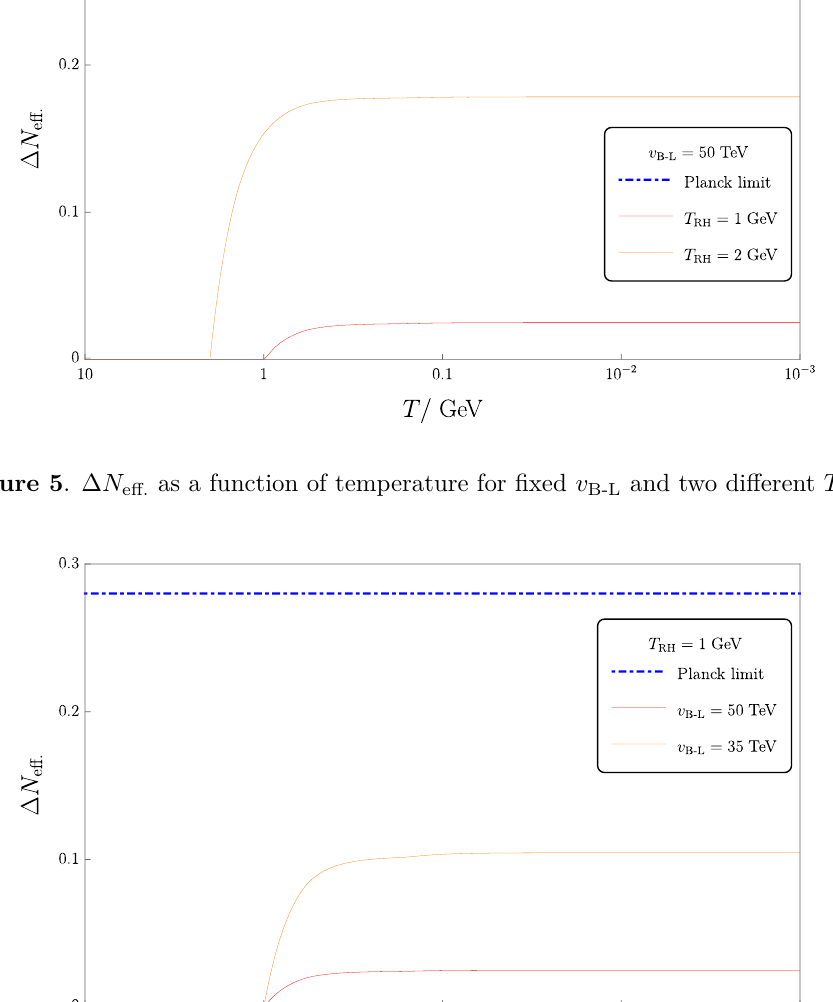
relativistic degrees of freedom in entropy and energy both decrease drastically when the quarks and gluons confine at T . To keep the relic density or ∆ N fixed one needs to QCD eff. compensate this increase of the integrand by allowing for a larger value of v , hence the B-L contours appear to be shifted to the right below T , which is why for illustration we QCD chose to display a straight line at the corresponding temperature. One should not forget that the factor of P in both numerators also decreases sharply below T , but is N i QCD i approximately cancelled by one of the factors in the denominator leaving one factor in the denominator leading to the previously explained